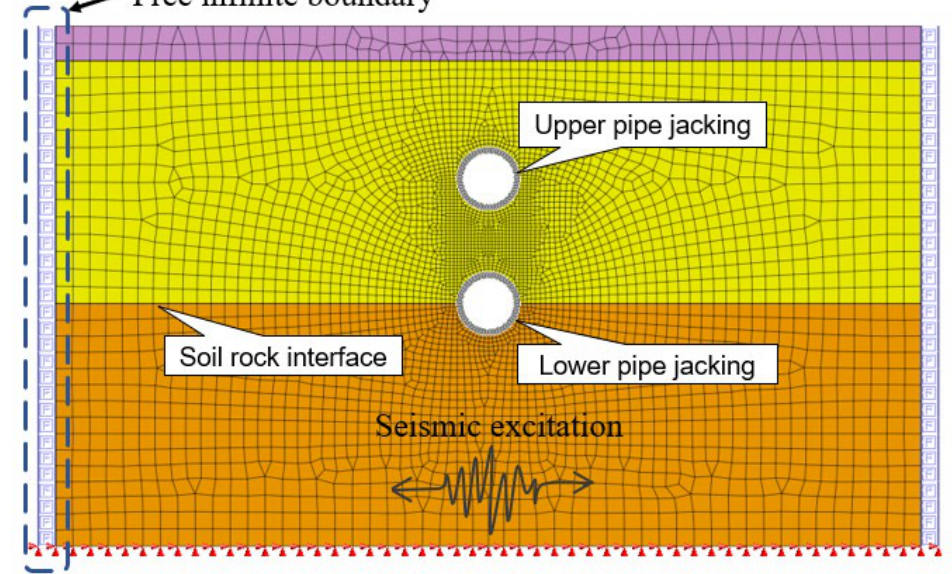
Figure 3. Finite element model mesh of vertical double pipe tunnel in soil rock assemblage strata.